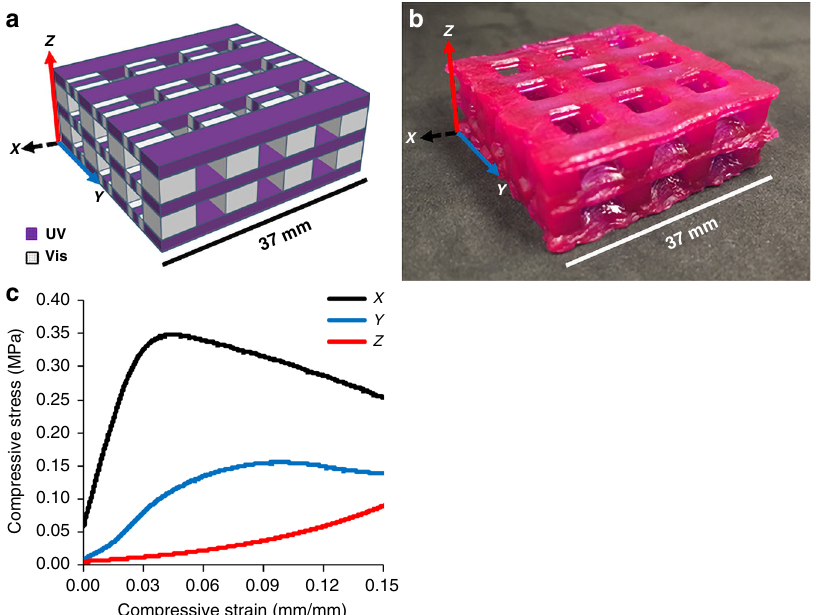
Fig. 4 Design, print, and representative stress – strain plot from compression testing of multimaterial HEA-2 printed specimen. a CAD model of tetragonal lattice. Purple corresponds to regions printed with UV light and white corresponds to regions printed with visible light. b Printed tetragonal lattice using HEA-2 MASC formulation. Sample printed with 1-min layer cure times, and then thermally post-processed at 100 °C for 10 min. Sample dimensions: 37 × 37 × 13 mm 3 . Nile Red was used as a dye to reduce visible light-induced outgrowth. c Representative stress-strain plots of compression along all three axes. Black = x -axis with stiff beams printed with UV light. Blue = y -axis with multimaterial beams printed with both UV and visible light. Red = z -axis dominated by soft beams printed with visible